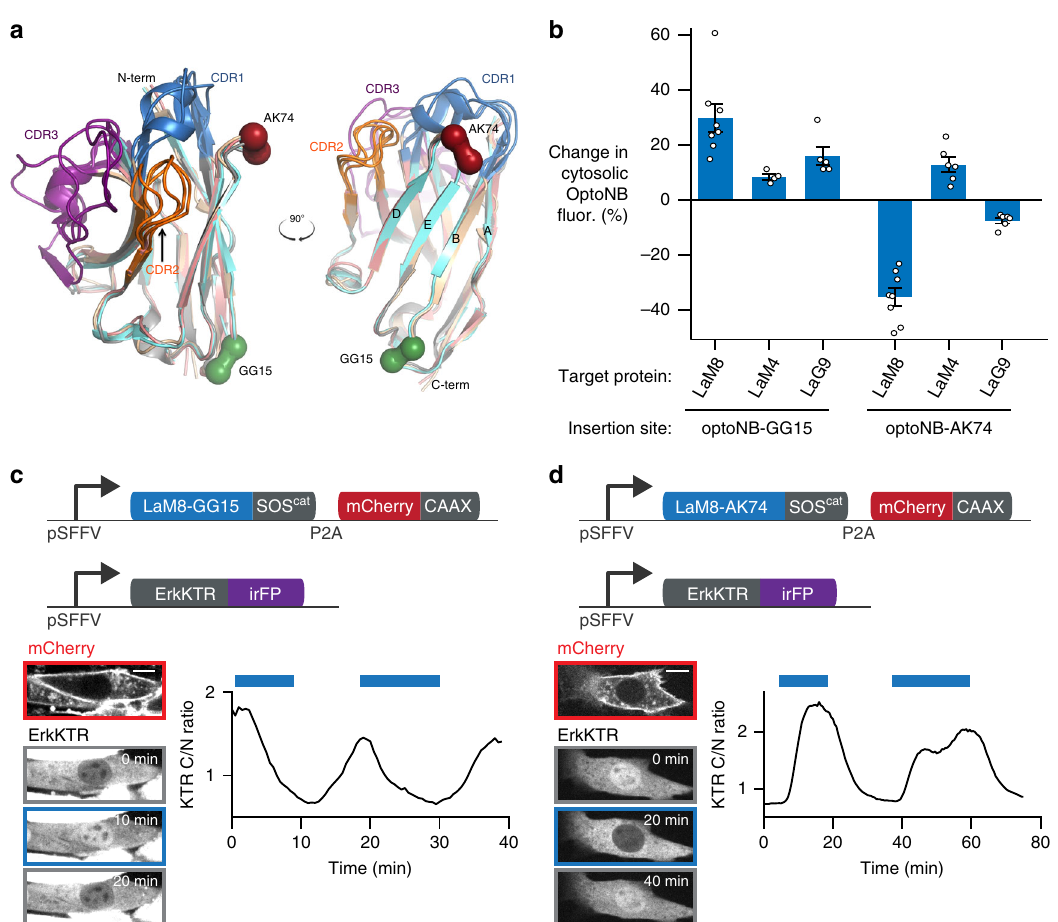
Fig. 3 OptoNBs can be deployed against multiple targets and used to control intracellular signaling. a Superimposed nanobody structures with diverse binding modes: the anti-GFP minimizer nanobody in gray (PDB ID: 3G9A), anti-EGFR 7D12 in blue (PDB ID: 4KRL), anti-VGLUT Nb9 in beige (PDB ID: 5OCL), anti-Gelsolin Nb11 in pink (PDB ID: 4S10), and anti-CD38 MU551 in green (PDB ID: 5F1O). The CDRs, GG15 position, and AK74 position are highlighted in colors as indicated. b Light-induced translocation from nucleus to cytosol of LaM8, LaM4, and LaG9 OptoNBs with LOV insertion at GG15 or AK74. The change in cytosolic intensity from the original, dark-equilibrated value is shown. Error bars indicate mean ± SEM for n = 8, 4, 5, 8, 6, and 6 cells, respectively. c , d NIH3T3 cell lines harboring OptoNB-controlled Ras/Erk pathway activity using LaM8-GG15 (in c ) and LaM8-AK74 (in d ). Upper diagrams show lentiviral constructs expressed in each cell: membrane-localized mCherry-CAAX, OptoNB-SOS cat , and a live-cell biosensor of Erk activity (ErkKTR- iRFP). Lower diagrams indicate mCherry and ErkKTR expression and localization for representative cells. Curves show the cytosolic-to-nuclear ratio of ErkKTR for a representative cell when pulsed with blue light (blue bars). Images are representative of three replicate experiments. Scale bars: 10 μ m. Source data are available as a Source data fi